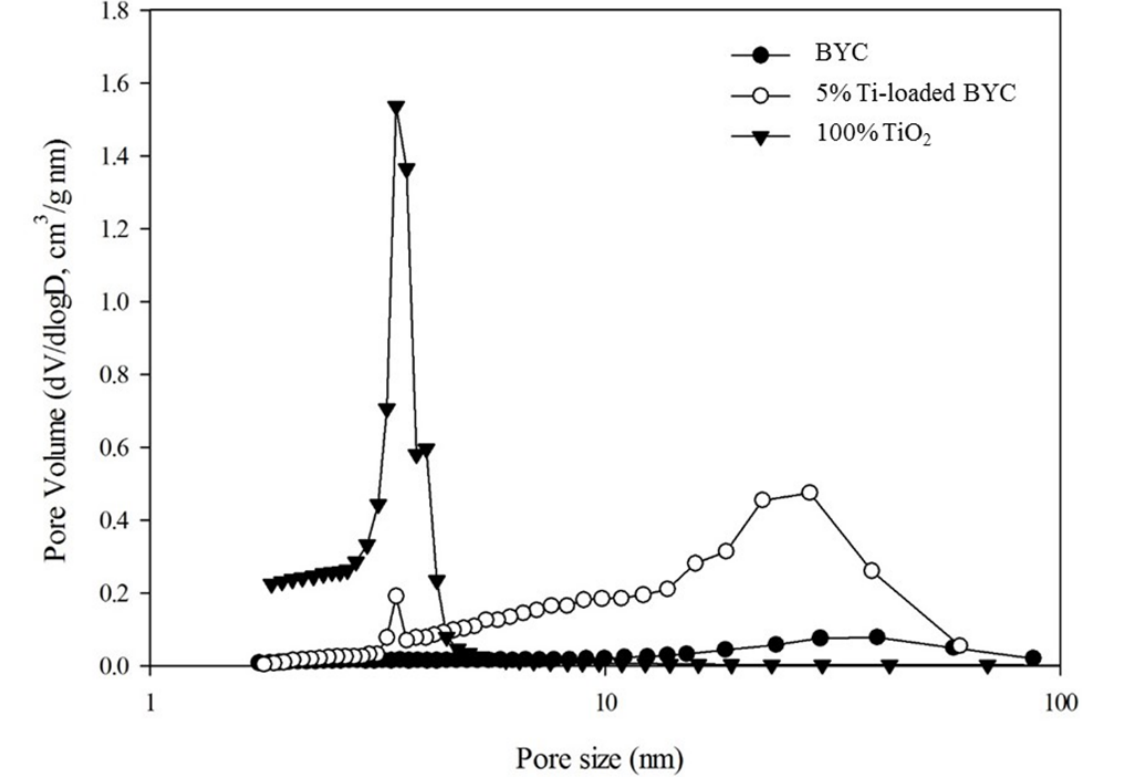
Figure 4. Pore size distribution of yttrium based adsorbents and titanium dioxide by BET